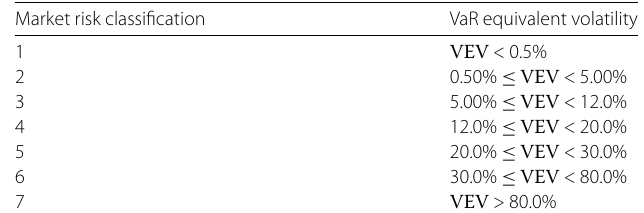
Table 1 Market risk classification Market risk